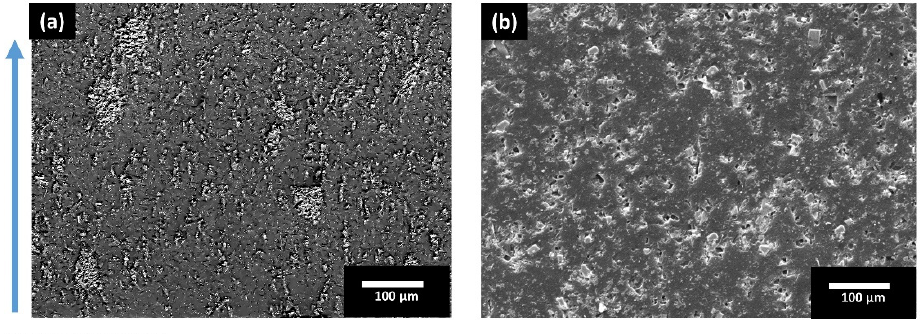
Figure 6. SEM micrographs of the control sample displaying the cross-section of KNLN-PLA composite: ( a ) after dielectrophoresis (DEP) process under 1 kV/mm and 1 kHz at 210 °C; ( b ) without electric field.